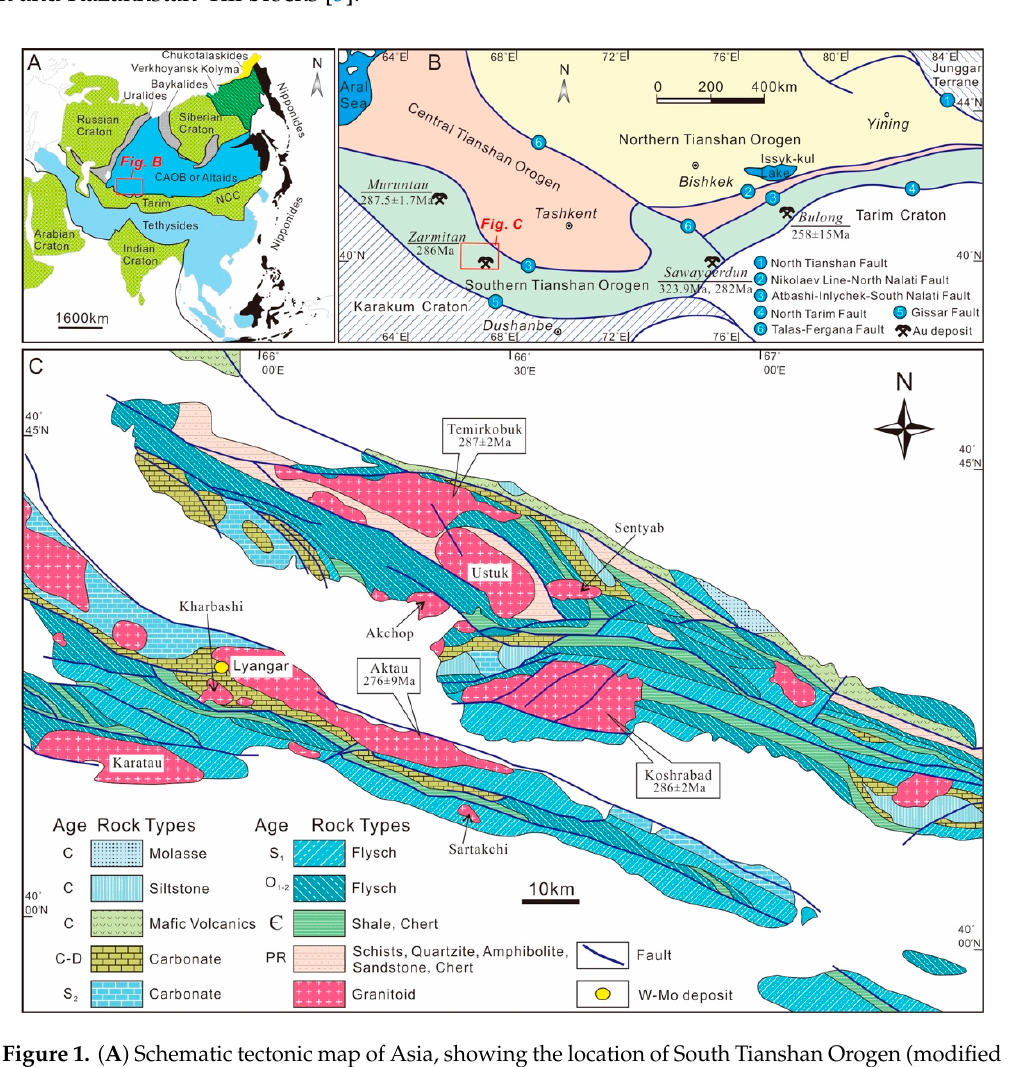
Figure 1. ( A ) Schematic tectonic map of Asia, showing the location of South Tianshan Orogen (modified after [4]). ( B ) Tectonic map of the South Tianshan Orogen and adjacent regions (modified after [35]). ( C ) Geologic map of the Nuratau area (modified after [18]). Abbreviations: NCC = North China Craton.